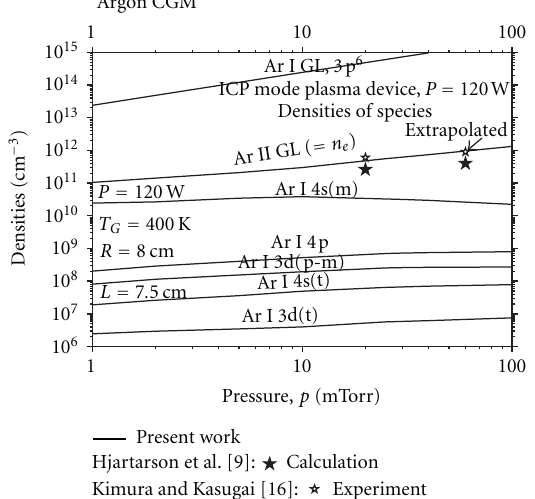
Figure 9: Calculated densities of species in the plasma reactor for 1mTorr < p < 100mTorr and comparison with values of Hjartarson et al. [9] and with those of Gudmundsson (quoted in [9]).